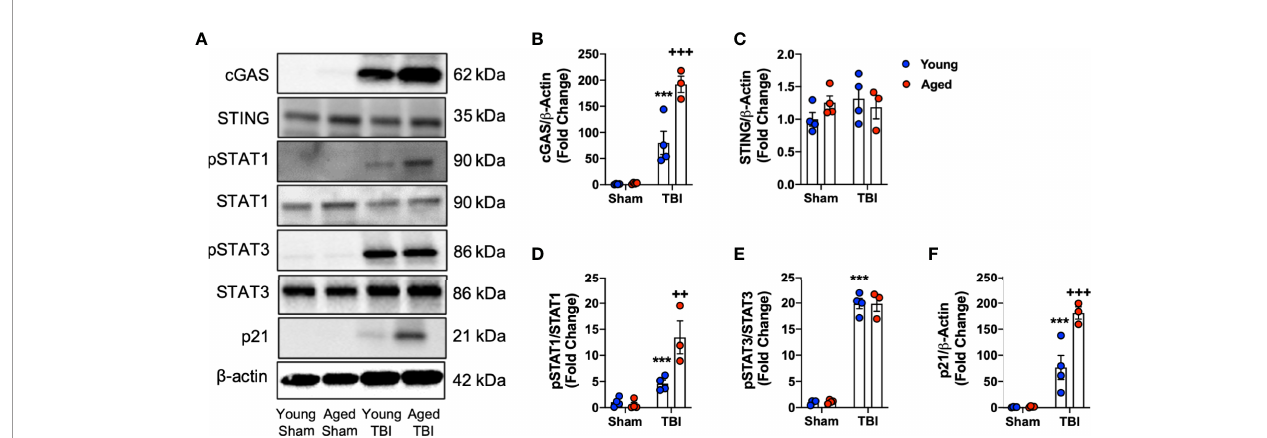
FIGURE 7 | Biochemical analysis of cGAS/STING and IFN-I signaling pathways in the cortex of young and aged sham and TBI mice. Cortical protein expression of cGAS, STING and other downstream mediators of IFN-I signaling was assessed by Western immunoblotting in young and aged Sham and TBI mice at 24 hours post-injury. Representative Western blots are shown in (A) . TBI increased expression of cGAS (p<0.0001, B ) protein compared to sham mice. The TBI effect was signi fi cantly increased in aged mice (cGAS p=0.0007, young TBI vs aged TBI). There was no effect of TBI or age on STING (C) protein expression. The expression of pSTAT1 protein was signi fi cantly increased in the cortex of TBI mice compared to sham mice (p=0.001, D ). The TBI effect was signi fi cantly increased in aged mice (p=0.0146, young TBI vs aged TBI). The expression of pSTAT3 protein was signi fi cantly increased in the cortex of TBI mice compared to sham mice (p<0.0001, E ). There was no age-related effect observed. TBI signi fi cantly increased p21 expression in young and aged mice (p<0.0001, F ). The TBI effect was signi fi cantly increased in aged mice (p<0.0001, young TBI vs aged TBI). Data expressed as Mean ± SEM. ***p < 0.001 vs. sham (effect of TBI) and ++ p < 0.01, +++ p < 0.001 young TBI vs aged TBI. Two-way ANOVA using Tukey post-hoc tests,